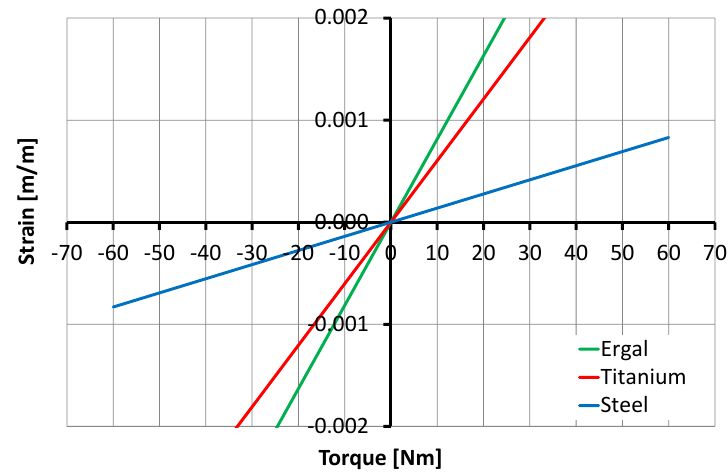
Figure 11. Relationship between the torque and the strain for three material studies.